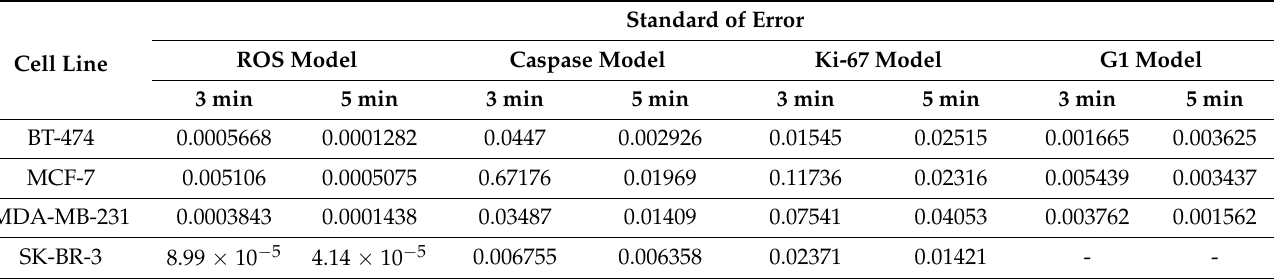
Table 6. Standard of error for cell proliferation